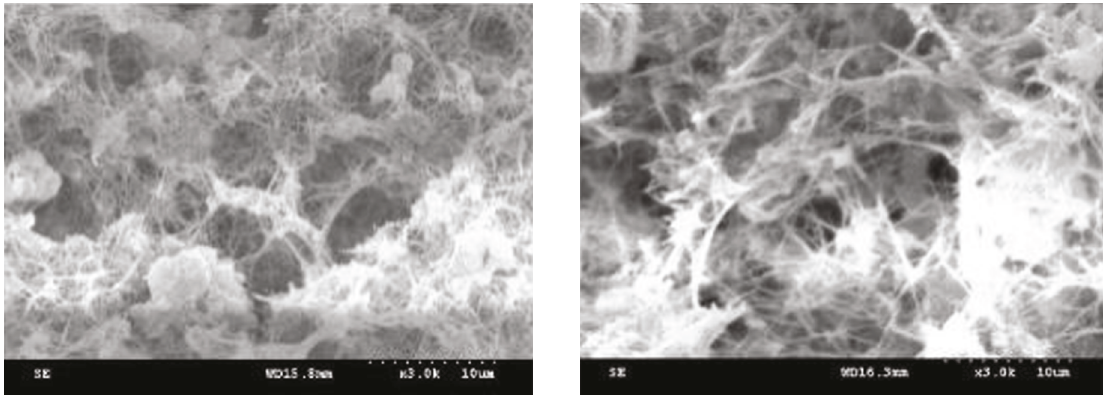
Figure 8: Network structure of ettringite crystals.